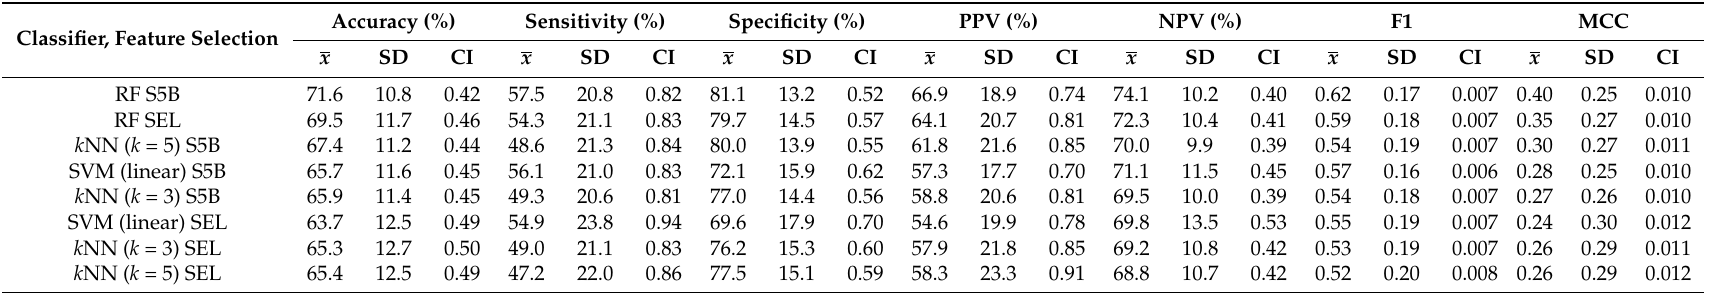
Table 7. Combined straight and turn-walking feature results for 2500-iteration random-shuffle-split cross validation (2500-RSS), ordered by ranked performance. PPV: positive predictive value, NPV: negative predictive value, MCC: Matthews correlation coefficient, S5B: select-5-best method, SEL: false positive and discovery rate method, RFE: recursive feature eliminator, RF: random forest, k NN: k -nearest neighbour, SVM: support vector machine, linear: linear kernel, x : mean, SD: standard deviation, CI: 95% confidence